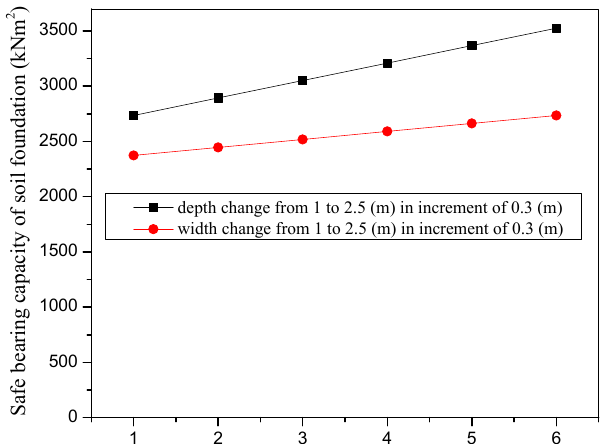
Figure 4: Fluctuation of safe bearing capacity of soil foundation (kN/m 2 ) Vs the mixed soil type.